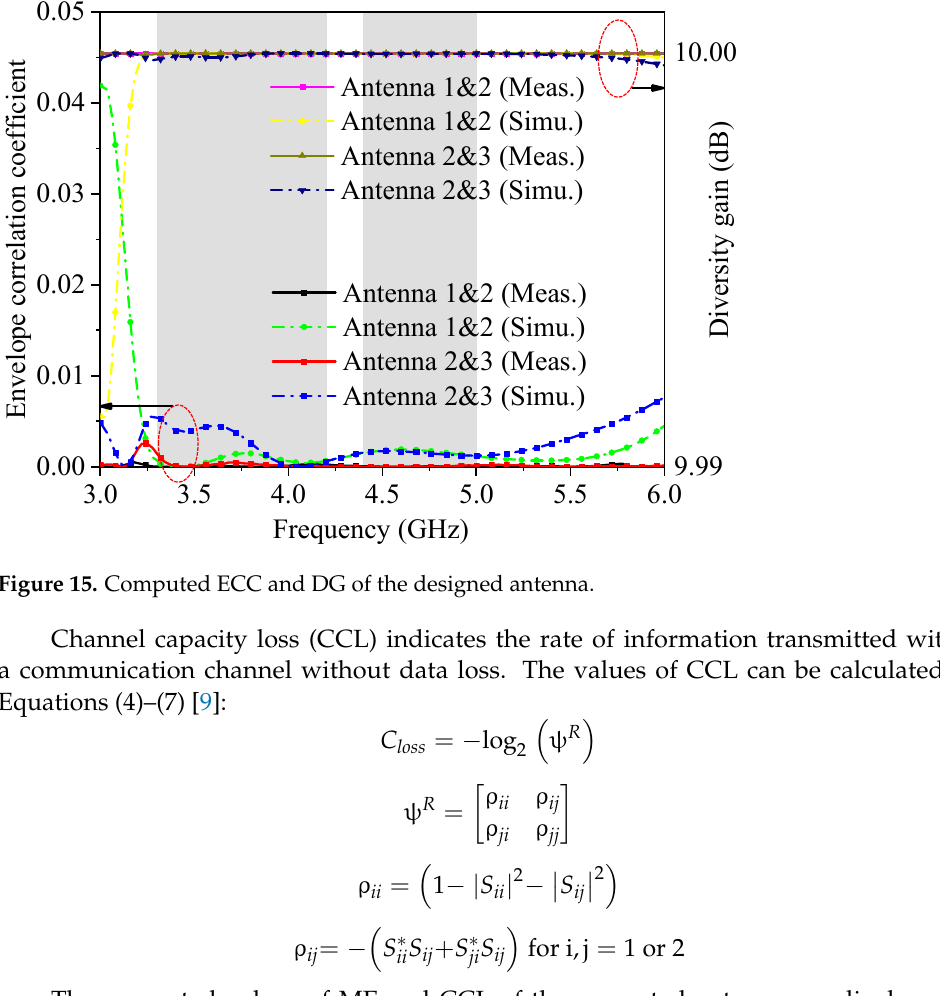
The computed values of ME and CCL of the presented antenna are displayed in